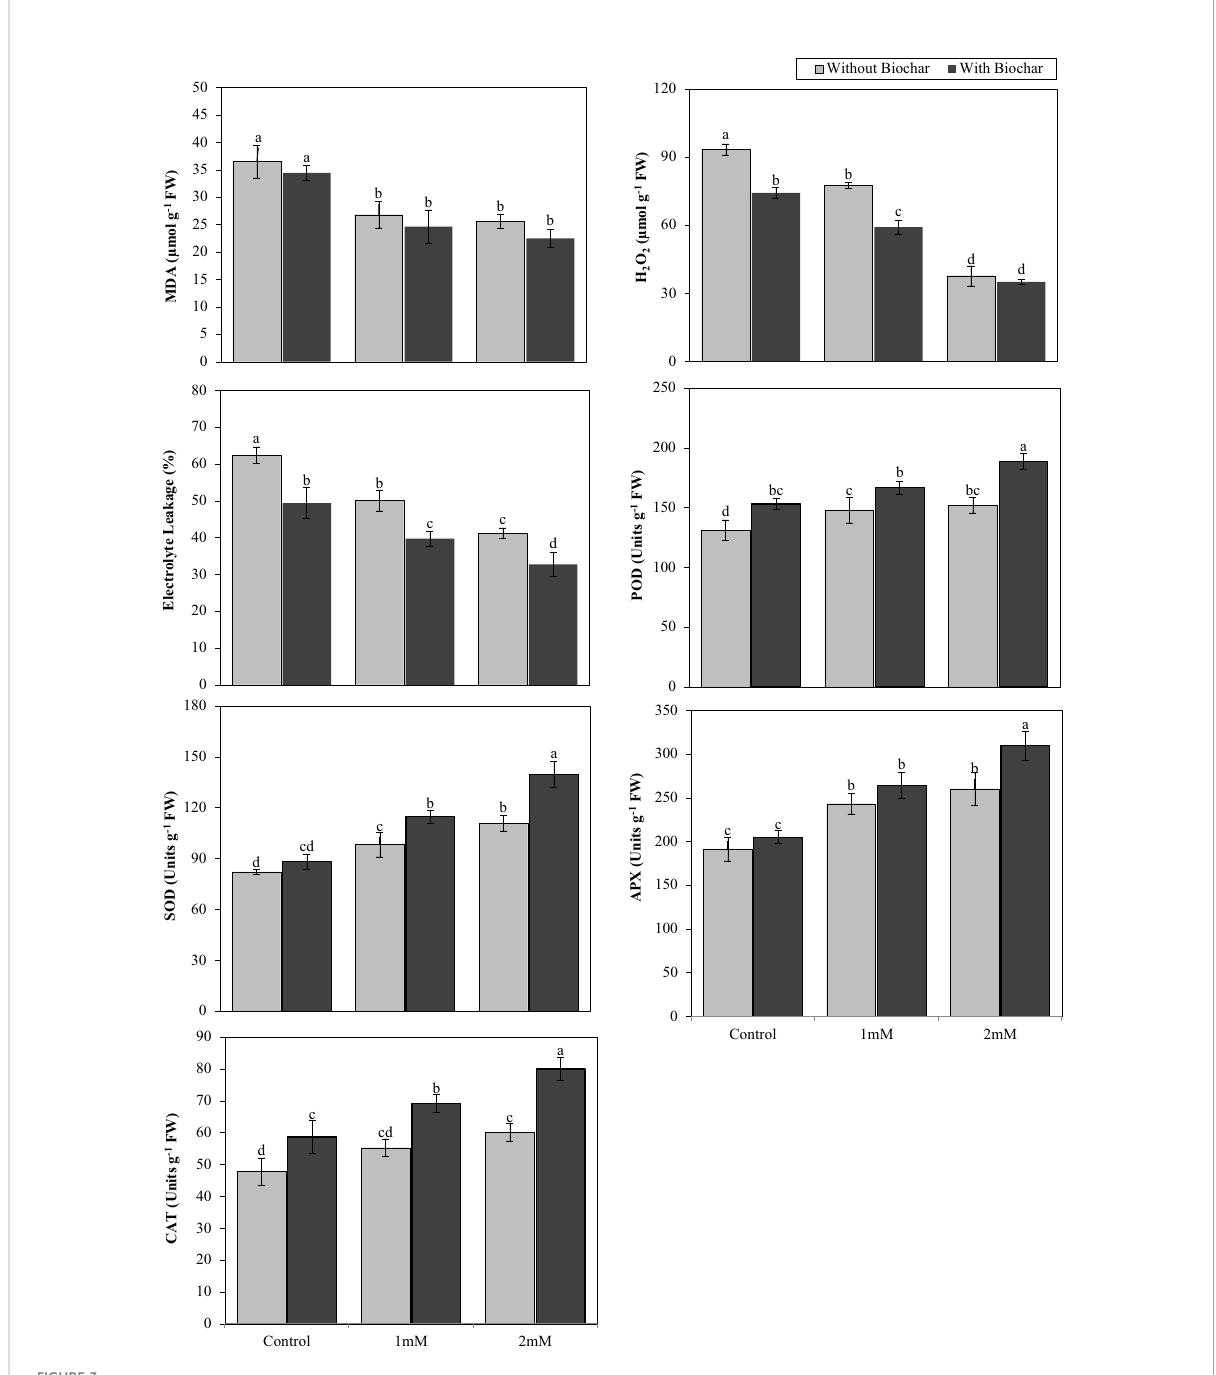
FIGURE 3 Data represent different levels of zinc – lysine (control 0, 1, 2 mM) with and without biochar on shoot length, shoot fresh weight, shoot dry weight, root fresh weight, root dry weight, grain weight, and spike length of wheat plant showing means of replicates (n = 3) ± standard deviation. Different letters indicate signi fi cant differences by Tukey HSD test at p ≤